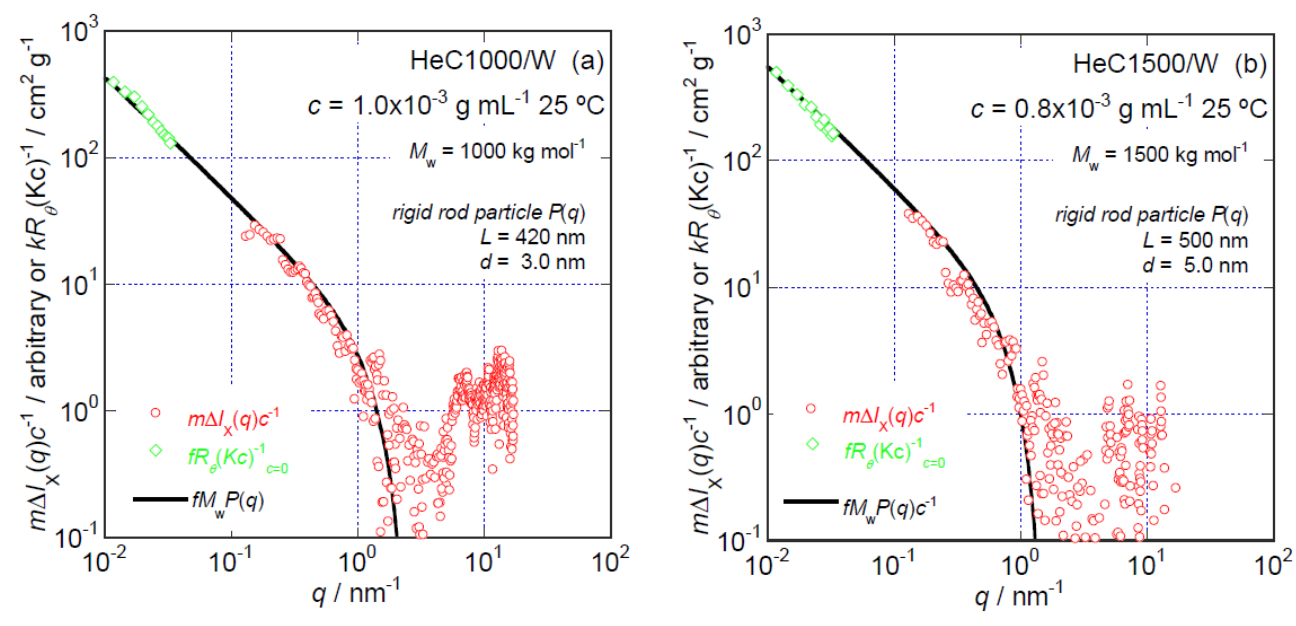
Figure 6. q dependencies of the m I X ( q ) c −1 (S-WAXS) data obtained for HeC1000 at c = 1.0 × 10 −3 g mL −1 ( a ) and those obtained for HeC1500 at c = 0.8 × 10 −3 g mL −1 at 25 °C ( b ). The same numerical constants as those used to generate the fitted curves shown in Figure 5b, f = 6.5 × 10 −4 cm 2 g −2 mol and m = 0.17, were employed.